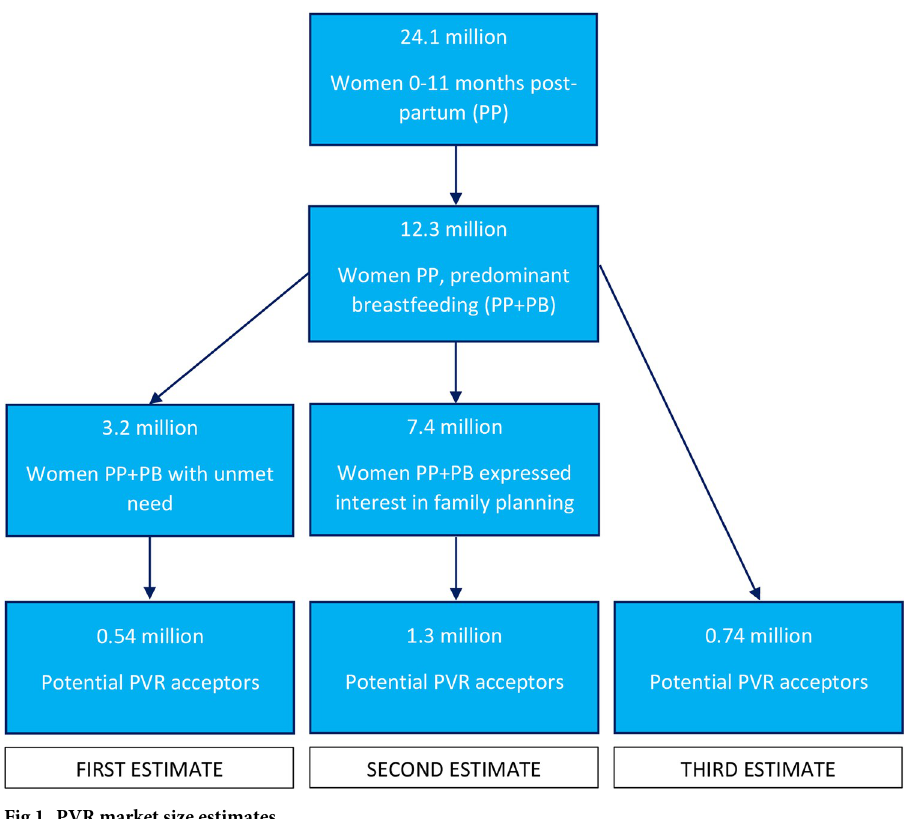
Fig 1. PVR market size